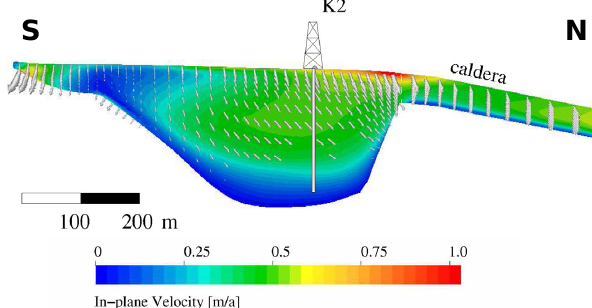
Fig. 2. Velocity field (absolute values as texture and direction vec- tors) simulated with Elmer/Ice in a north–south transect of the Gor- shkov crater glacier through the K2